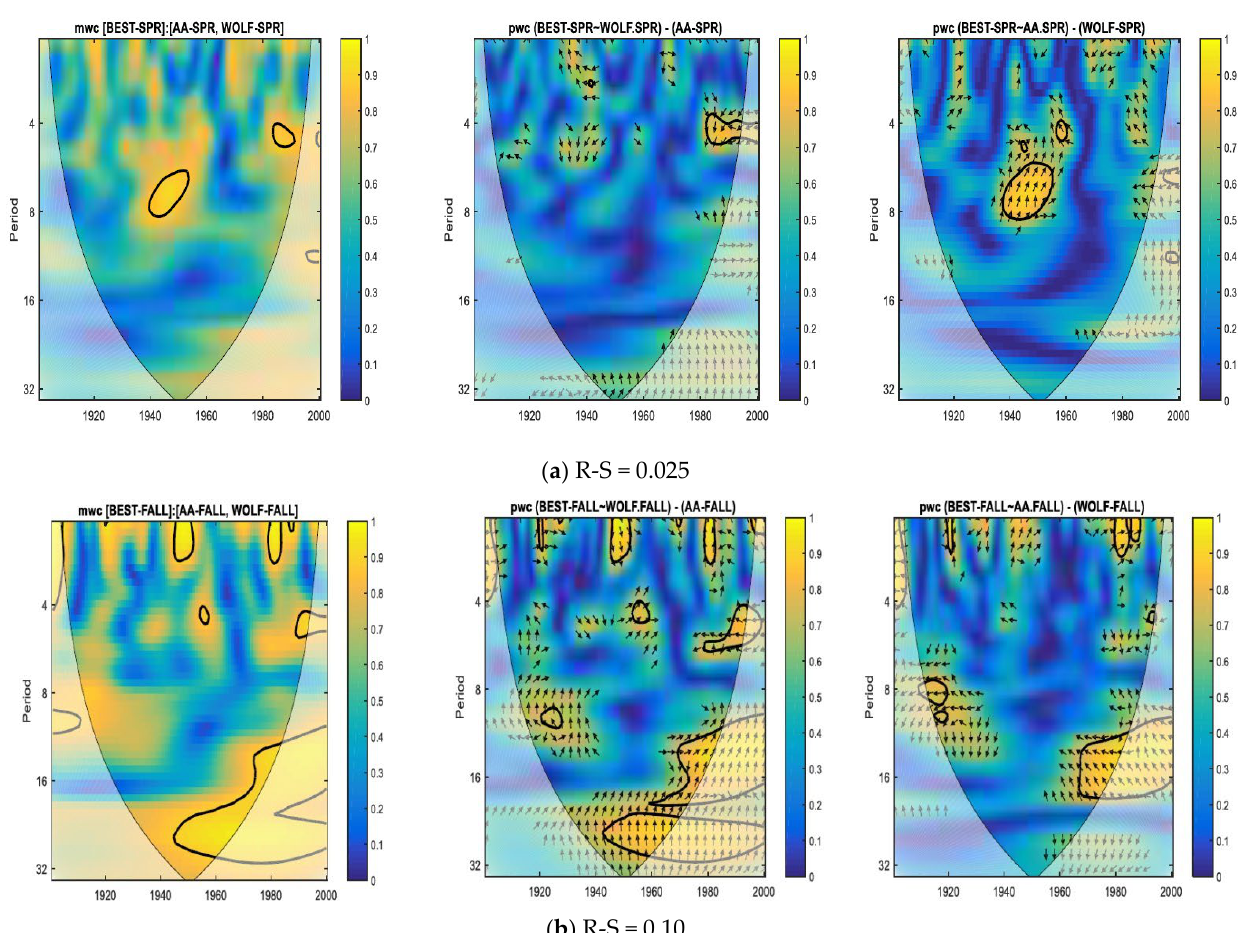
Figure 5. ( a ) Multiple wavelet coherence ( mwc ) between BEST and the two predictors aa (AA) and Wolf Number (WOLF) during spring ( left panel ); partial wavelet coherence ( pwc ) between BEST and Wolf number, excluding the effect of aa ( middle panel ), and pwc between BEST and aa , excluding the effect of Wolf number ( right panel ). ( b ) Same as ( a ) but for fall.